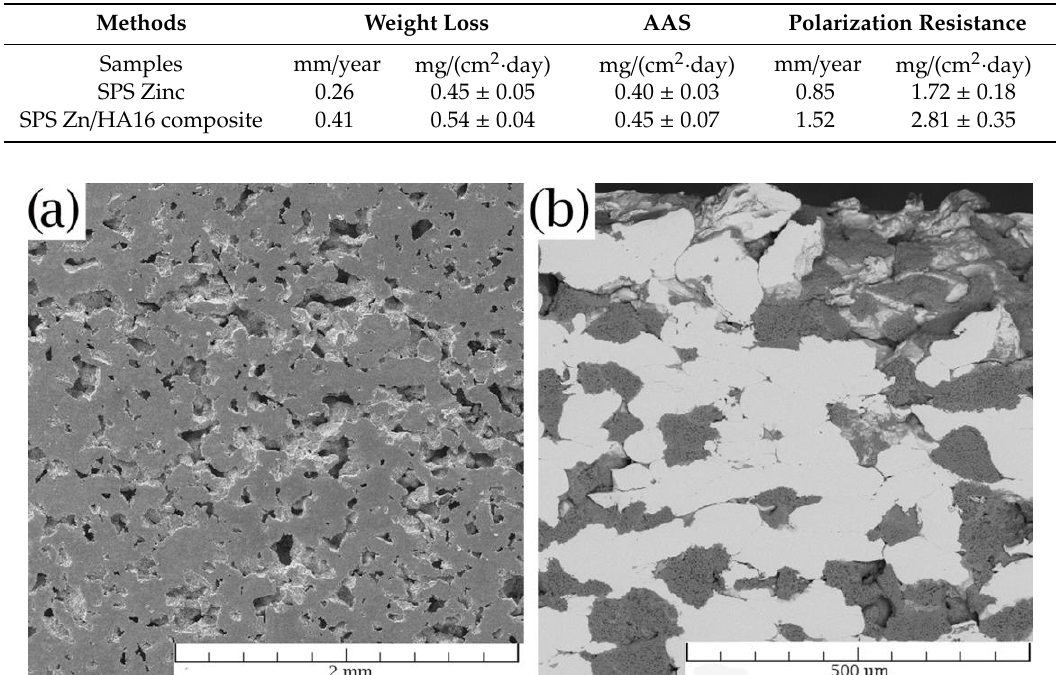
Figure 10. Surface of the Zn / HA composite after the pickling ( a ) of the corrosion products and ( b ) cross-section surface after the corrosion test.